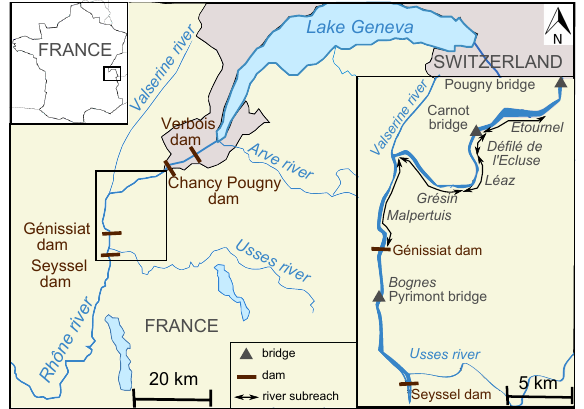
Fig. 1. Location of the study site.